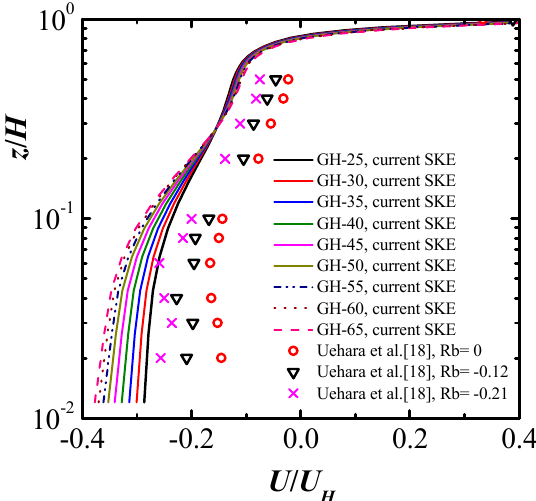
Figure 8. Distributions of normalized mean streamwise velocity along vertical centerline of the TSC.